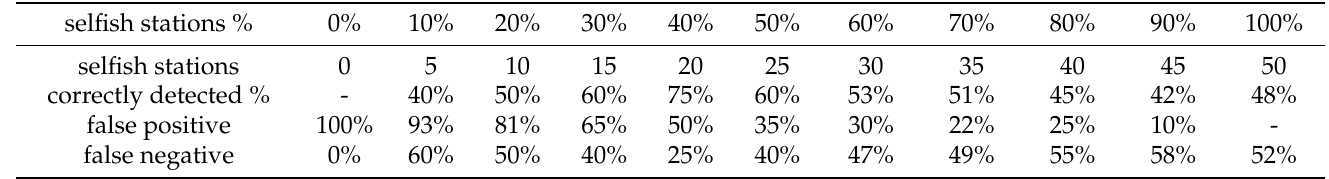
Table 4. Principal-agent detection method for 50 stations and 2 slots in TCP IP camera